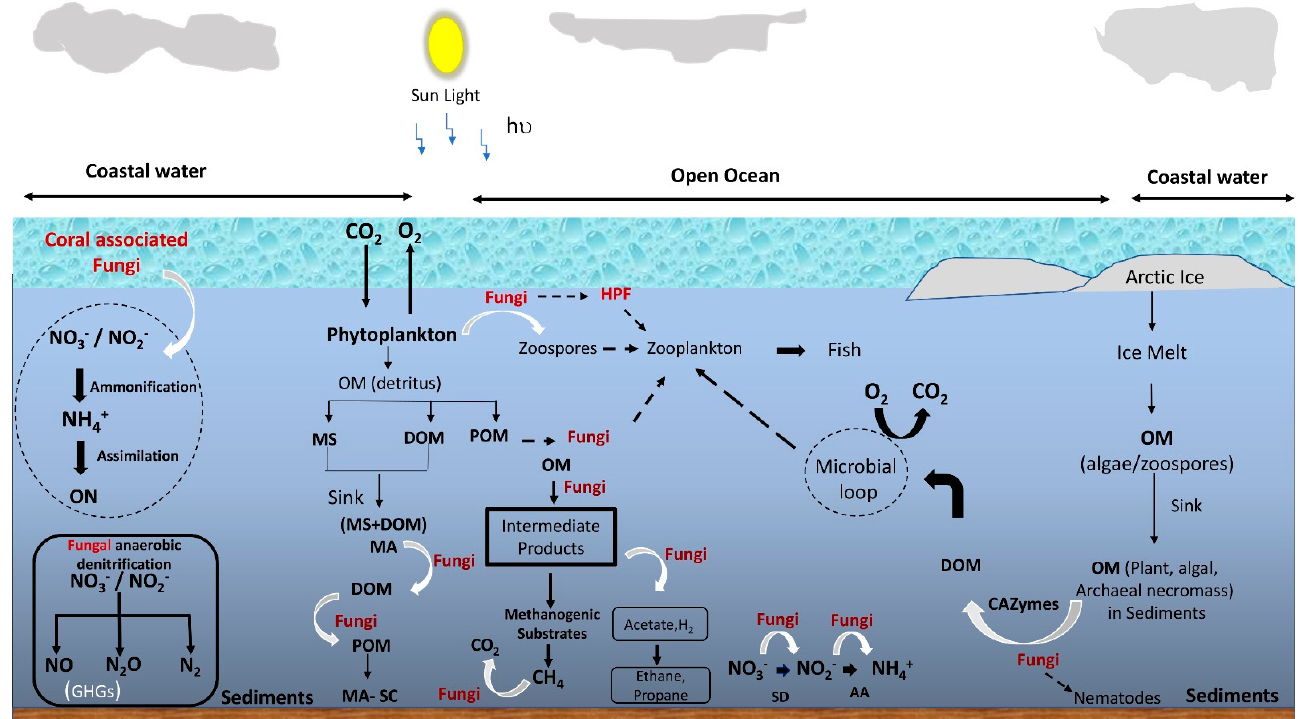
Figure 2. Schematic representation of the overview of possible roles of fungi in the marine food web and biogeochemical cycling. OM = organic matter; DOM = dissolved organic matter; MS = marine snow; POM = particulate organic matter; HPF = hyper parasitic fungi; SD = suboxic denitrification; AA = anaerobic ammonification; GHG = greenhouse gas; MA = macroaggregate; MA-SC = macroaggregate-sequestered carbon; ON = organic nitrogen. Black dotted arrows indicate feeding and white curved arrows indicate fungal involvement in the conversion.